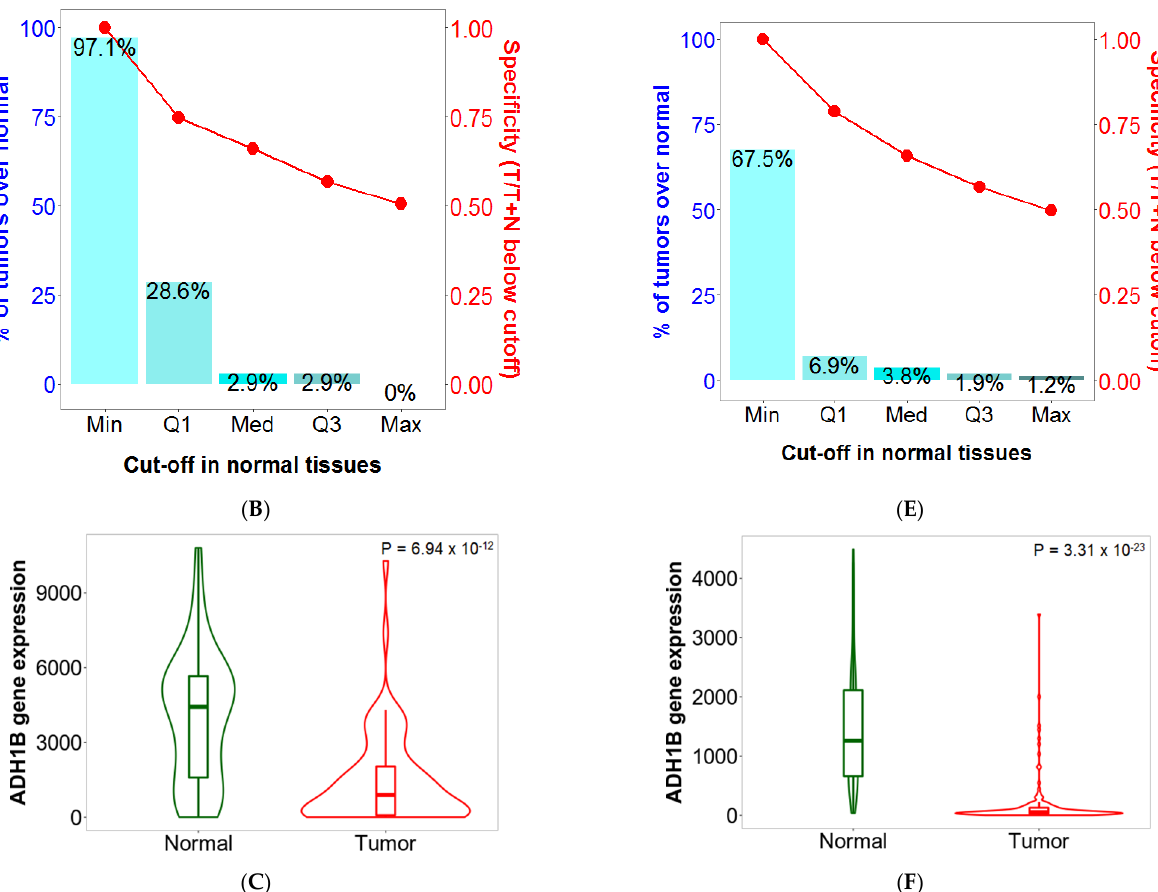
Figure 3. Boxplots ( A , D ), bar charts ( B , E ) and violin plots ( C,F ) of ADH1B gene expression in breast (left) and colon cancer (right) when comparing paired normal and tumor gene array data. The bars represent the proportions of tumor samples that show higher expression of the selected gene compared to normal samples at each of the quantile cutoff values (minimum, 1st quartile, median, 3rd quartile, maximum). Specificity is calculated by dividing the number of tumor samples with the sum of tumor and normal samples below each given cutoff. In cases where the fold change was over 1, those “ over ” were used instead of those “ below ”.